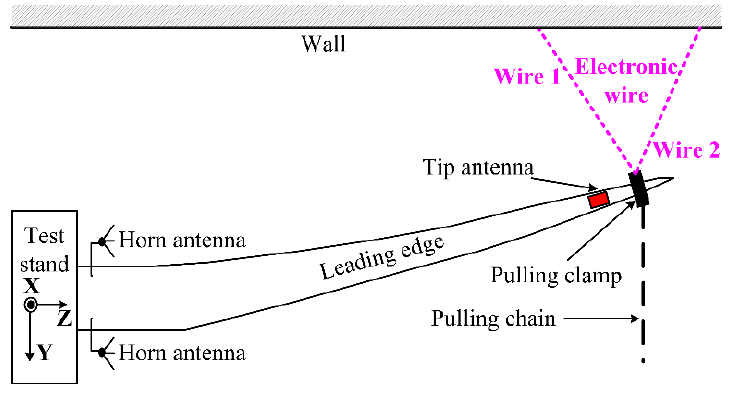
Figure 4. Electronic wire